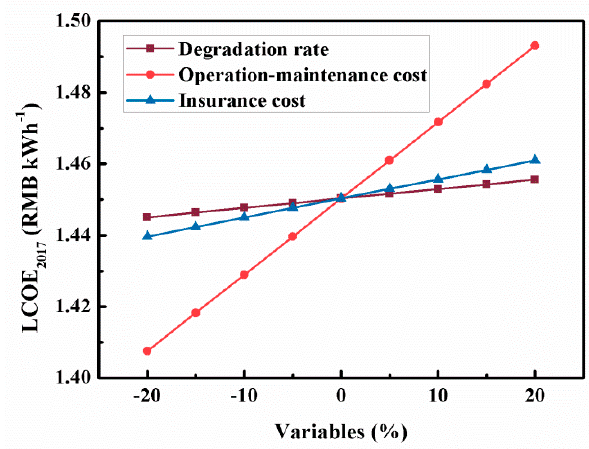
Figure 12. Sensitivity analysis of degradation rate, operation-maintenance cost, and insurance cost.